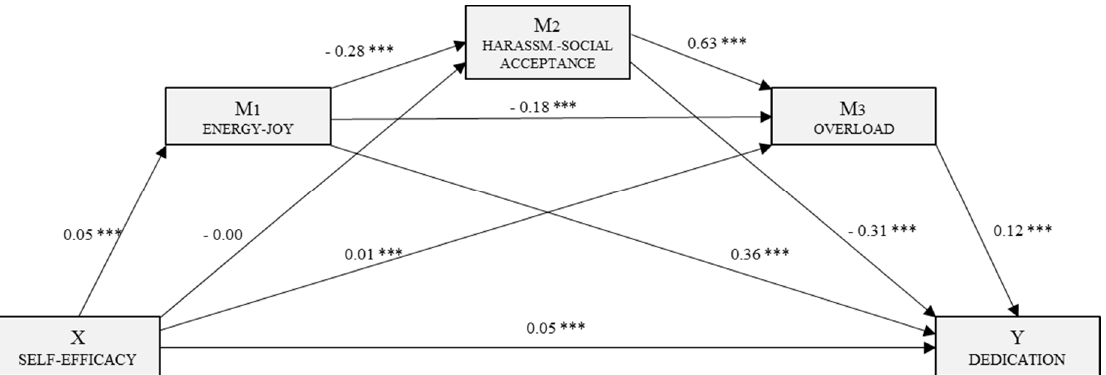
Figure 2. Multiple mediation model of perceived stress in the relationship between self ‐ efficacy and the engagement dimension, Dedication. *** p < 0.001.